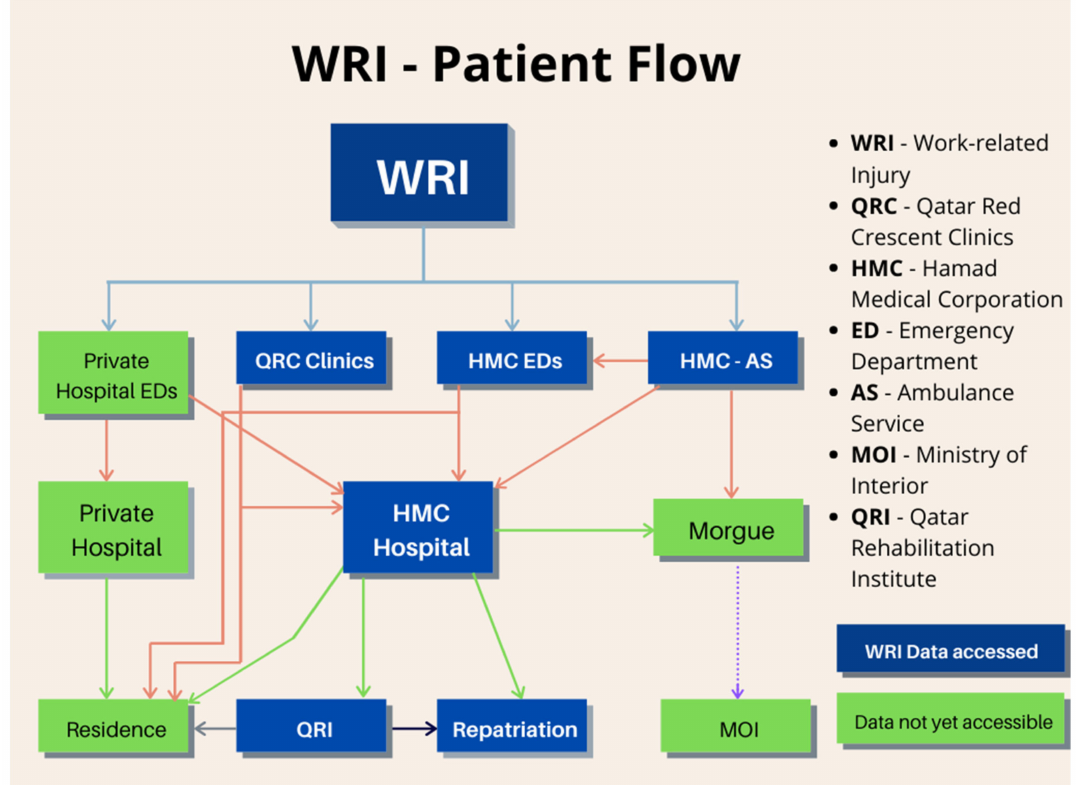
Figure 2. Mapping of the existent data sources and flow of patients with WRIs in